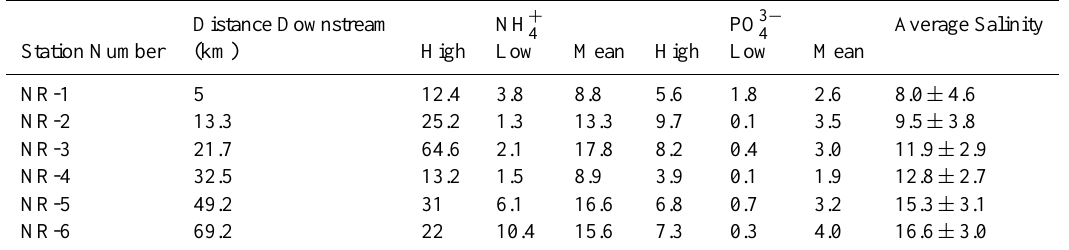
Table 1. Sampling location downstream distances from New Bern and diffusive flux variability (mgN or Pm − 2 d − 1 ) for all stations. Distance